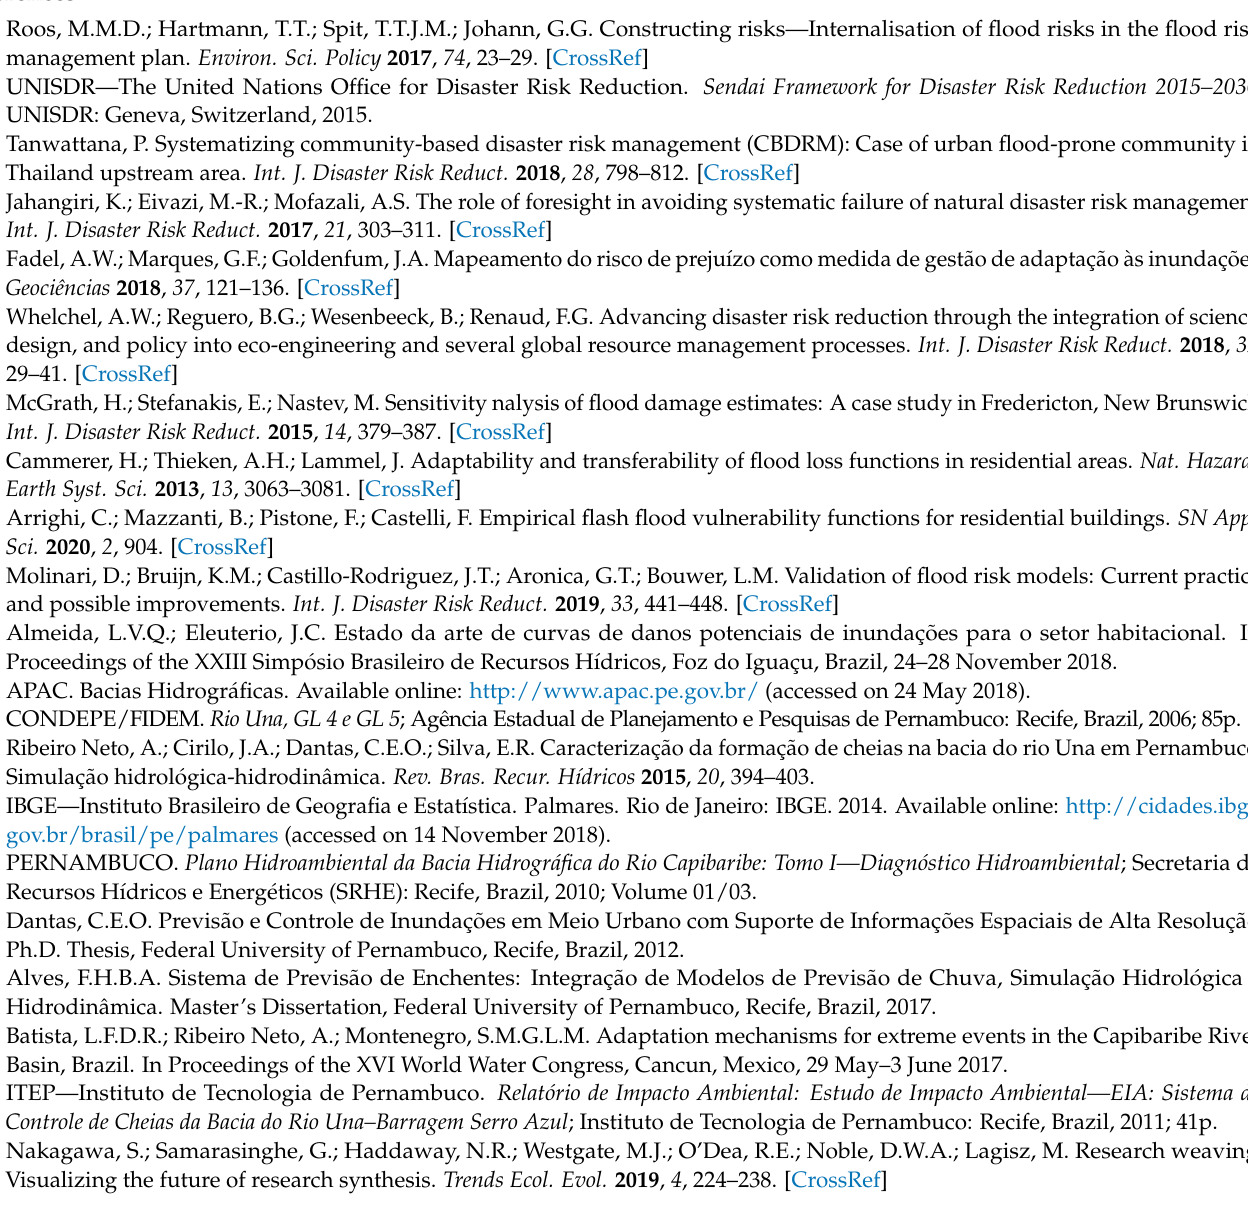
the buildings, Table S1: Main features of standard single-family home designs; Table S2: Multiplier factor of standard property contents